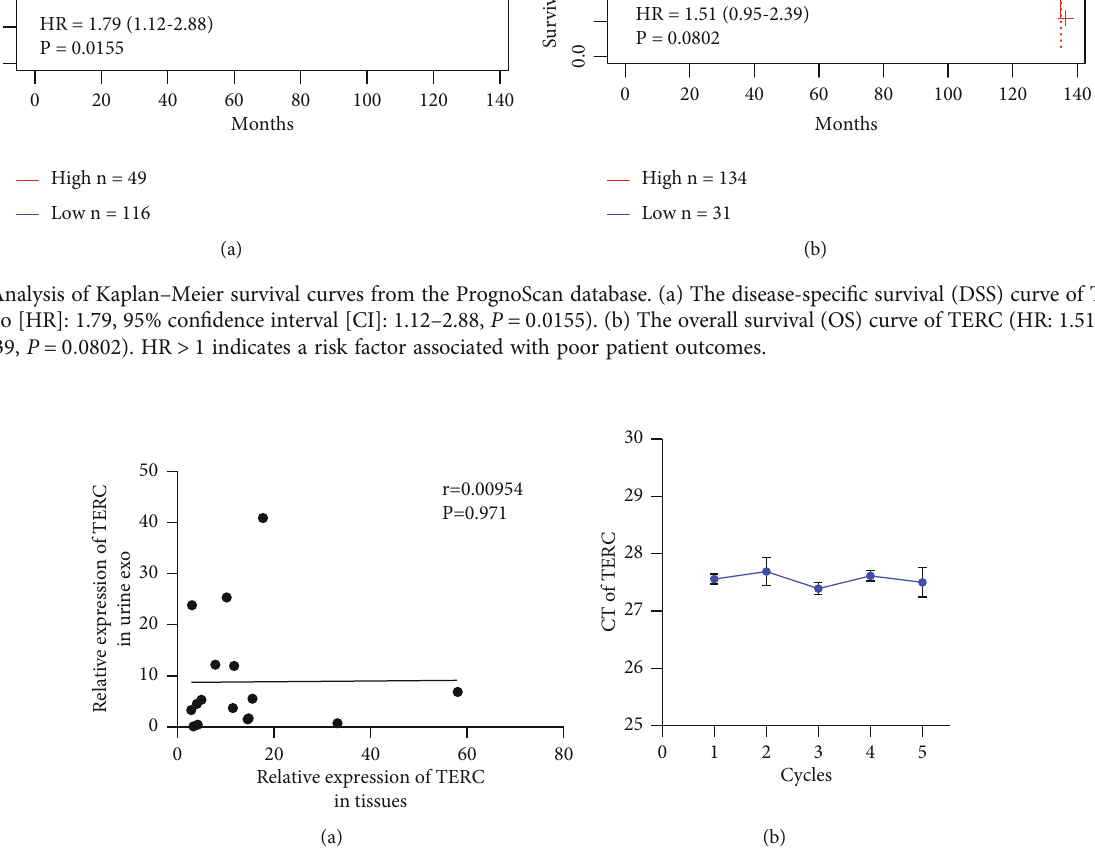
Figure 6: Correlation analysis of telomerase RNA component (TERC) levels in di ff erent sample types and its stability in exosomes. (a) TERC expression in tissues was uncorrelated with that in urine exosomes ( r = 0 : 00954 , P = 0 : 971 ). (c) Exosomal TERC levels after one to fi ve freeze-thaw cycles of urine samples. Results are presented as mean ± SD .